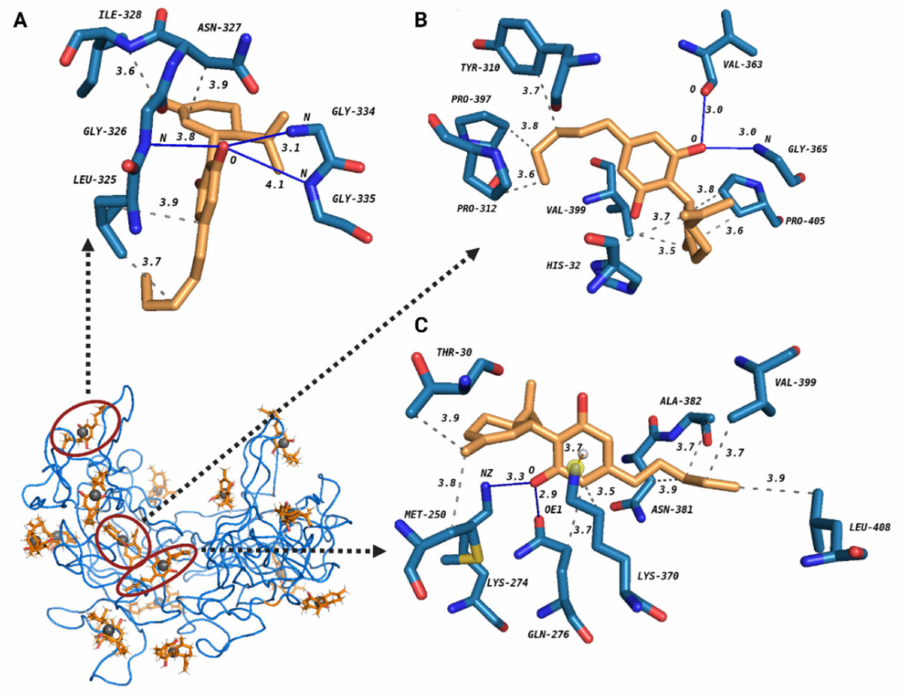
Figure 10. The 3D graphical image of three best tau-CBD docking complexes predicted by Achilles platform Tau protein and CBD are shown in blue and orange, respectively. The grey spheres are pseudo atoms. The best docking pose for three best-fitted clusters of tau-CBD interaction is presented in detail as complex A, complex B, and complex C. Hydrophobic interactions (in dash line), hydrogen bonds (in blue line) and one pi-cation interaction (in red line) as well as the distances between the donor and the acceptor are shown in all three tau-CBD